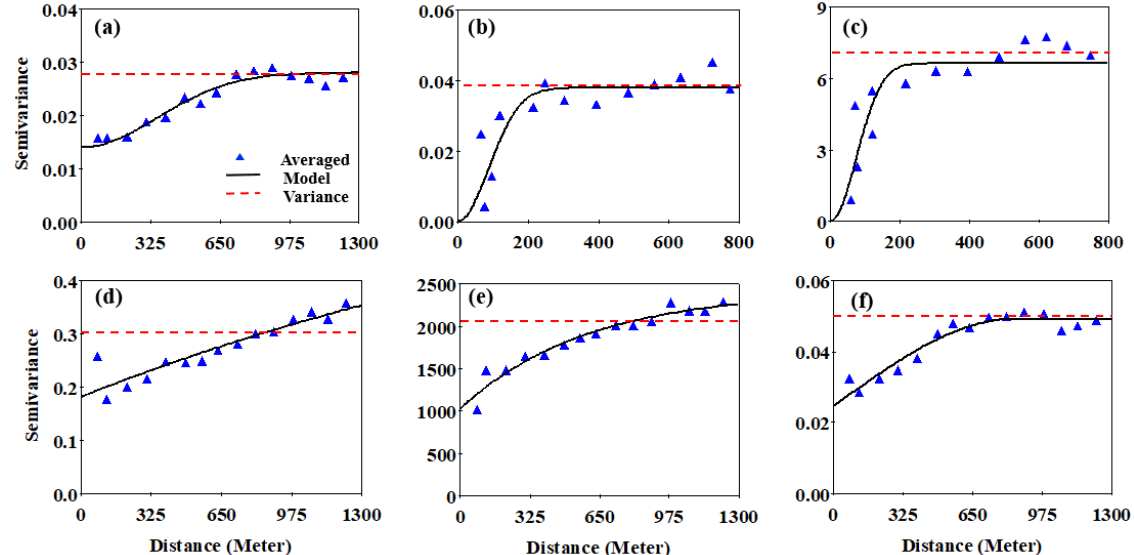
Figure 1. Variograms and respective models of the measured soil variables and their respective variograms models. ( a ) Soil pH, Gaussian, ( b ) TN, Gaussian, ( c ) OM, Gaussian, ( d ) AP, exponential, ( e ) AK, exponential, ( f ) ECa, spherical. The sample variance of the entire area is represented by the dotted line in each figure. Parameter estimates of the respective models are given in Table 2. Caution: note the differing scaling of the x-axis and y-axis of each figure.